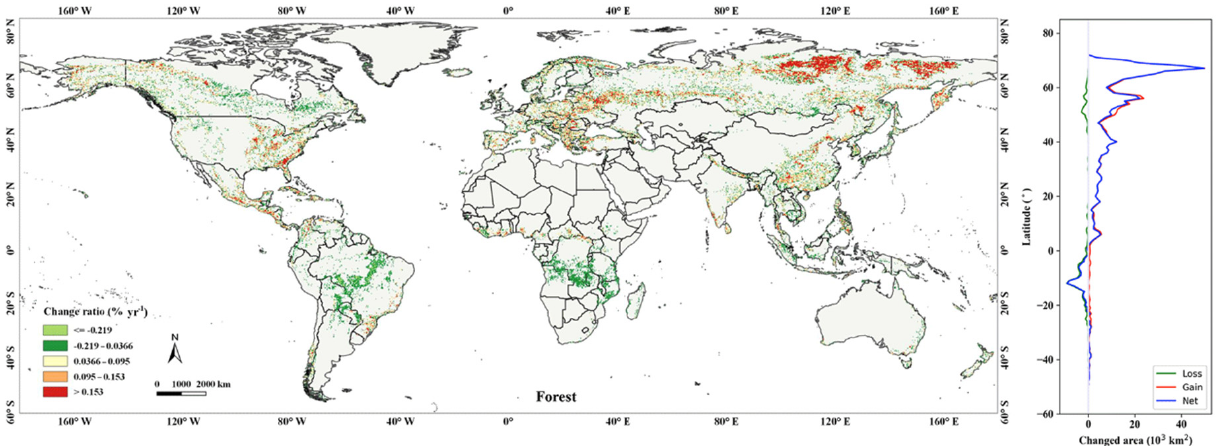
Figure 3. Percentage of annual change in forest cover at global level, the red spots in Siberia and Eastern Europe display an increase in forest cover. The green spots in central Africa, Amazonia, and Canada continued to decrease. Source Liu 2020.